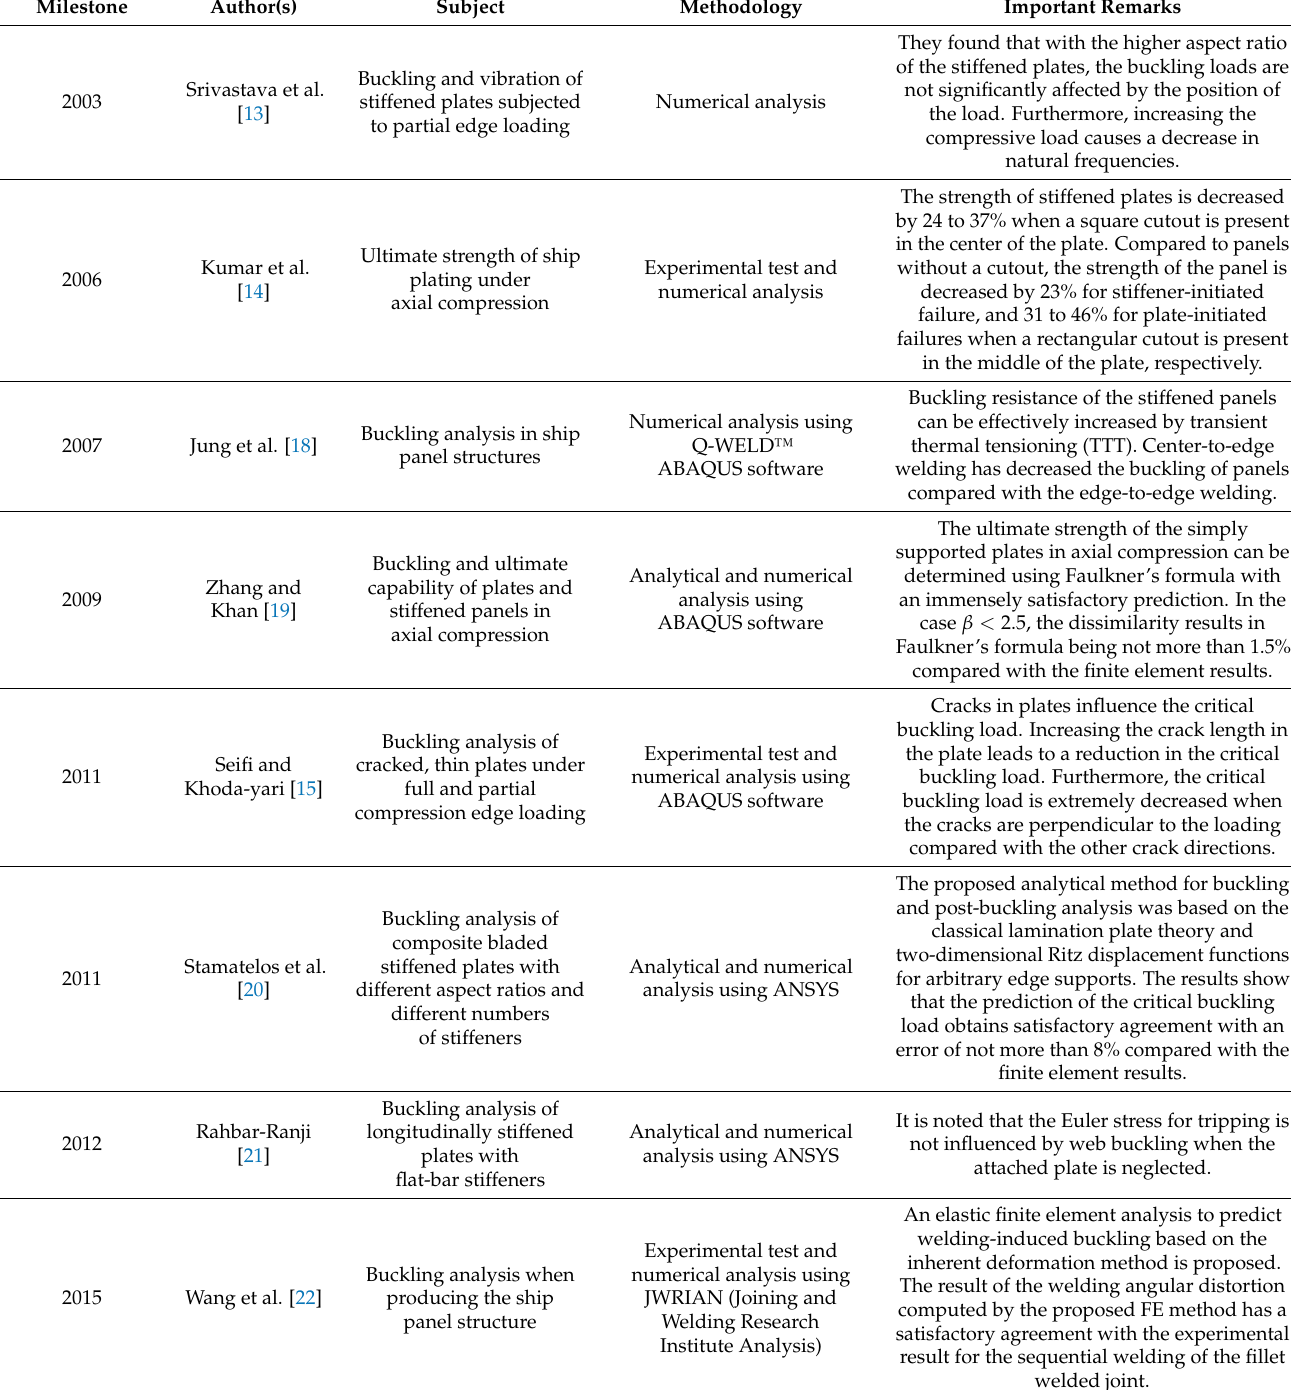
Table 1. Milestone research on the buckling analysis of the plate and stiffened